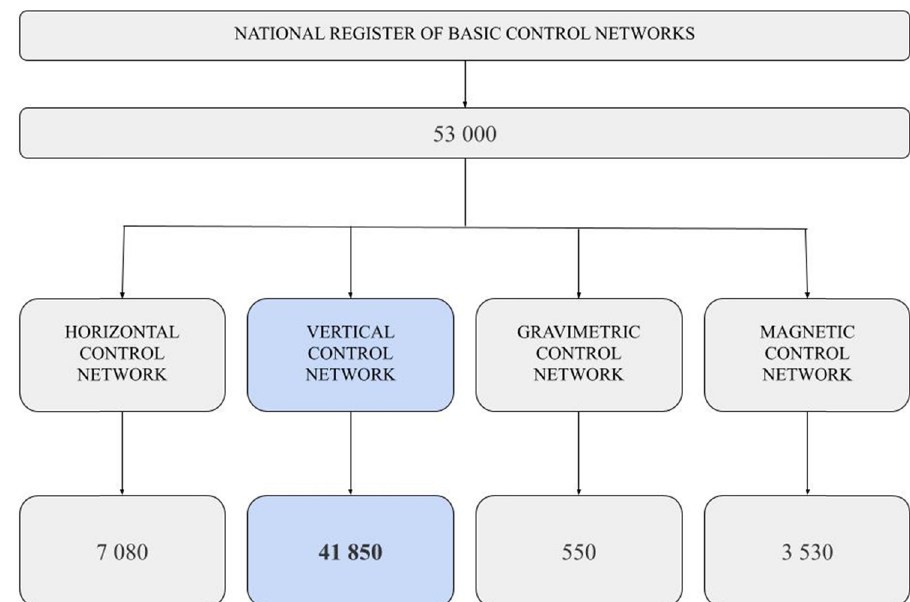
Figure 5: Number of points of geodetic network ( GUGiK 2022c )